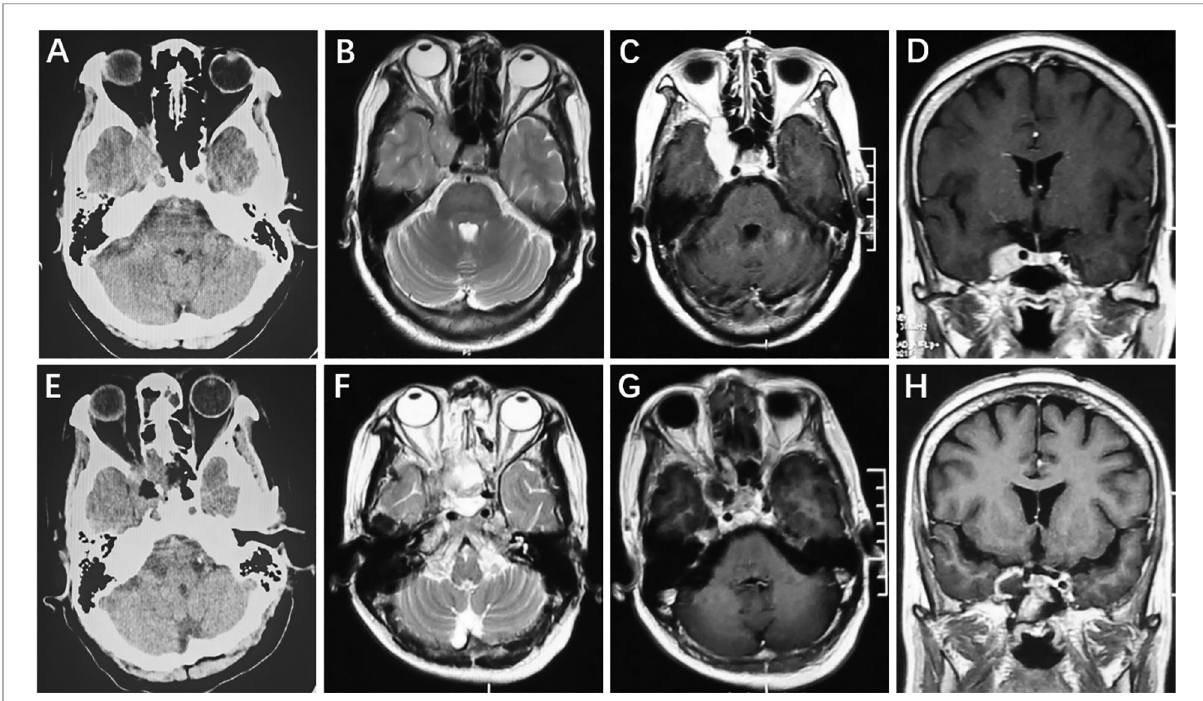
FIGURE 1 Right intracavernous HPC. Preoperative axial CT showed a slightly hyperintense lesion in the right cavernous sinus ( A ). Cranial axial MRI showed slight hyperintensity on T2-weighted imaging ( B ). After enhancement, the axial and coronal MRI showed homogeneous enhancement ( C,D ). Postoperative CT ( E ) and MRI ( F – H ) revealed that the tumor was completely